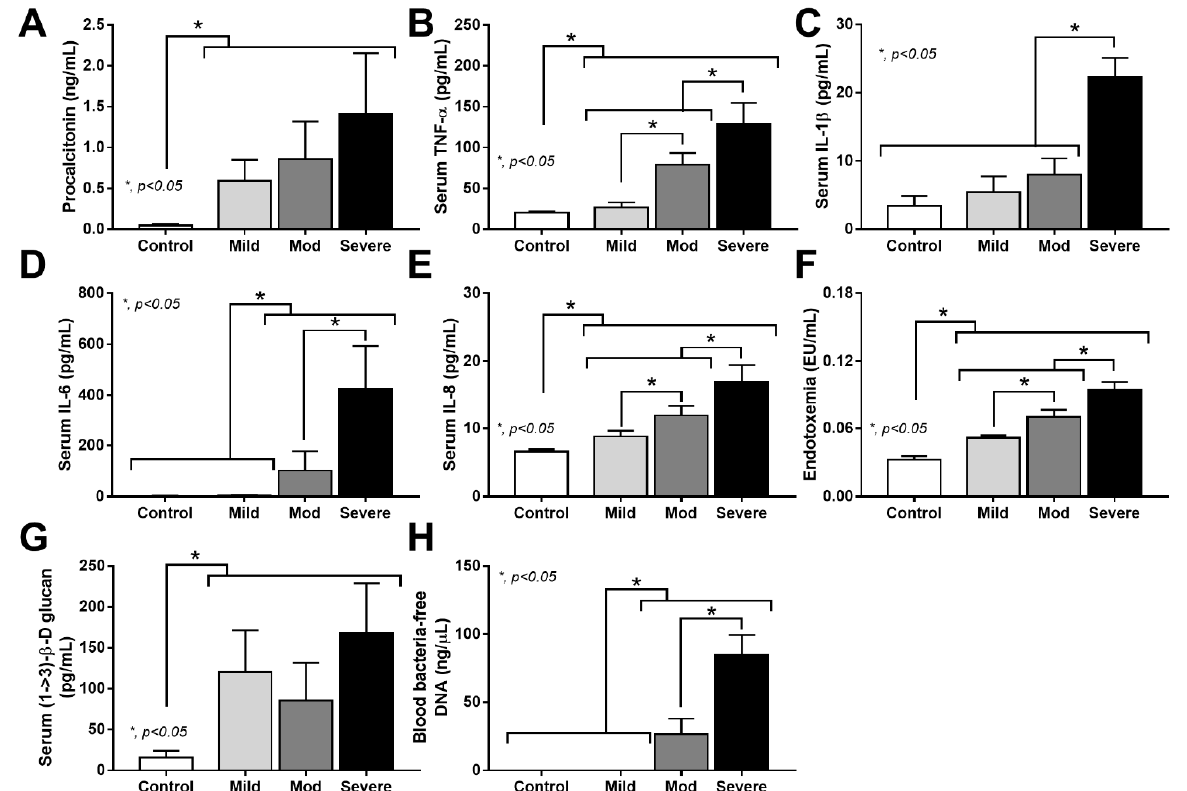
Figure 2. Characteristics of patients with COVID-19 in different severities—mild ( n = 27), moderate ( n = 28), and severe ( n = 20), versus healthy control ( n = 15), as indicated by procalcitonin ( A ), serum cytokines (TNF- α , IL-1 β , IL-6, and IL-8) ( B – E ), endotoxemia ( F ), serum (1 → 3)- β -D-glucan ( G ), and blood-bacteria-free DNA ( H )—are demonstrated. *— p < 0.05 between the indicated groups as determined by ANOVA with Tukey’s